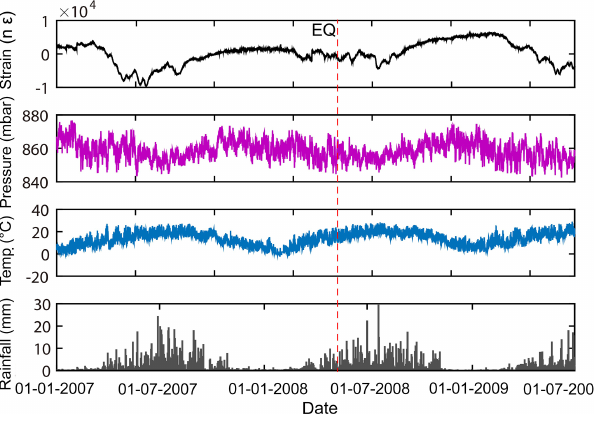
Figure 11. Borehole stain, air pressure, temperature and rainfall variations during study period at Guza station.